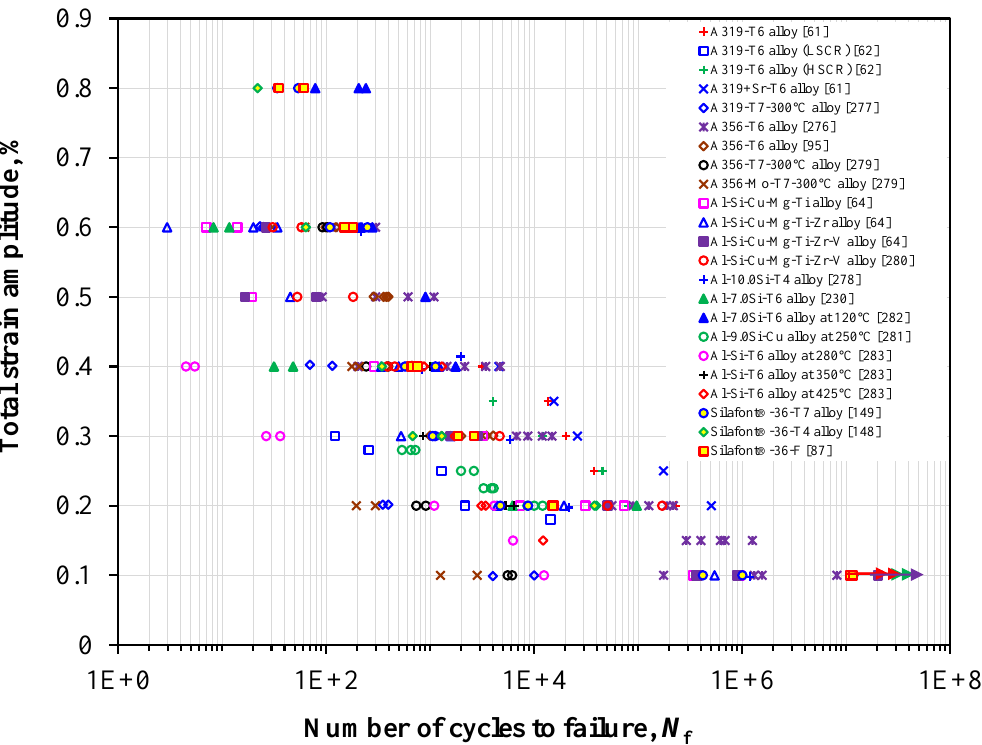
Figure 14. Summary of LCF properties for recently developed cast Al-Si alloys [61,62,64,86,87,95,148,149,230,276 – 283].